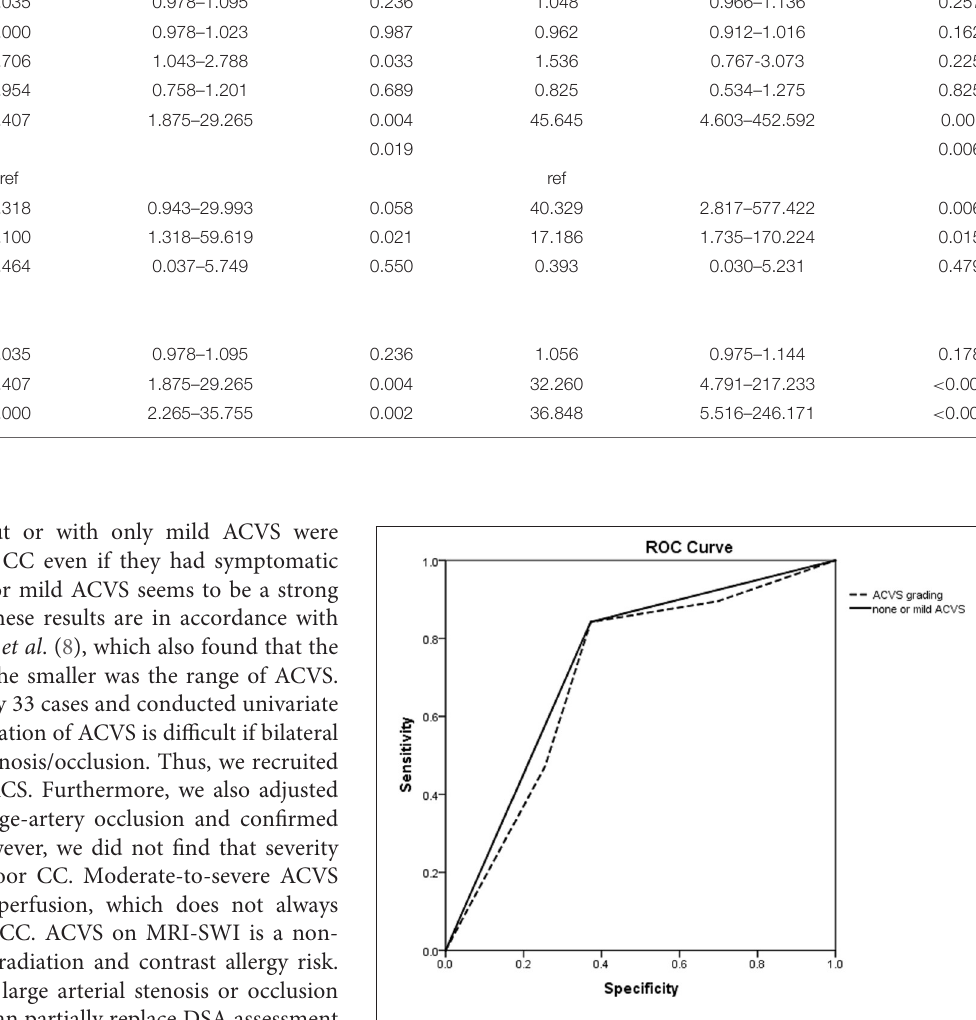
FIGURE 3 | ROC curve of ACVS to predict a good collateral circulation as confirmed by DSA. ROC curve showing the predictive ability of ACVS grading (dotted line) and none or mild ACVS (solid line) for a collateral circulation. ROC, receiver operating characteristic; ACVS, asymmetric cortical vein